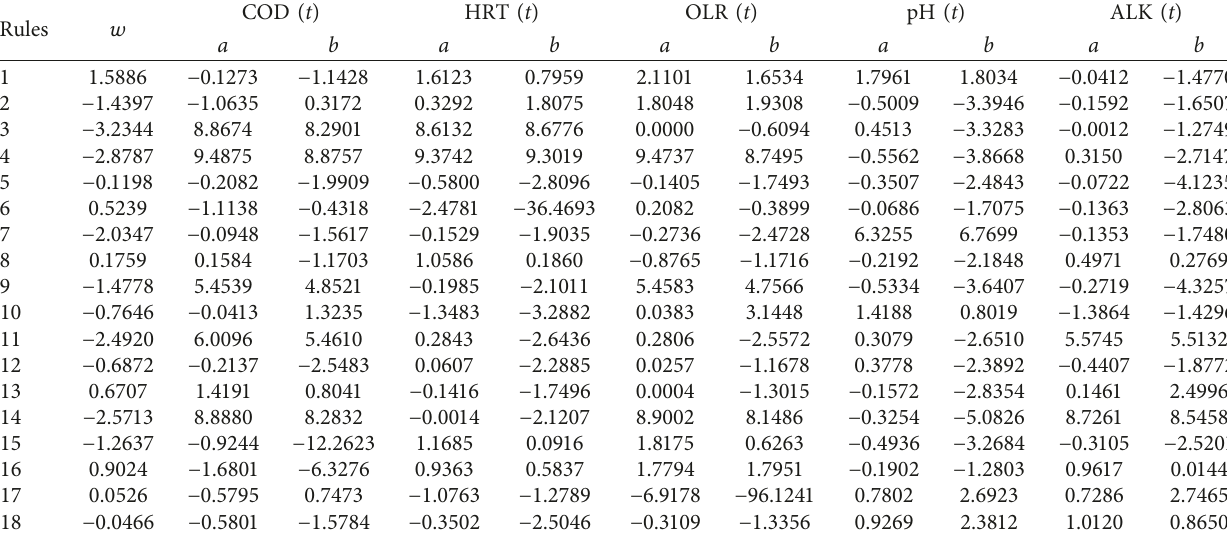
Table 2: Wavelet layer parameters of the